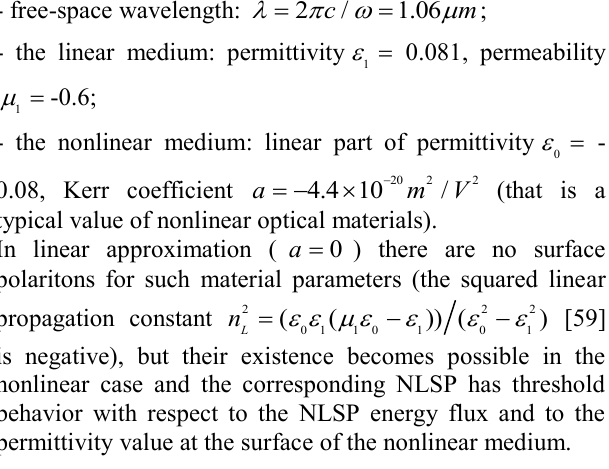
Figure 2. The NLSP propagation constant n vs. the permittivity at the surface of the nonlinear medium   . For